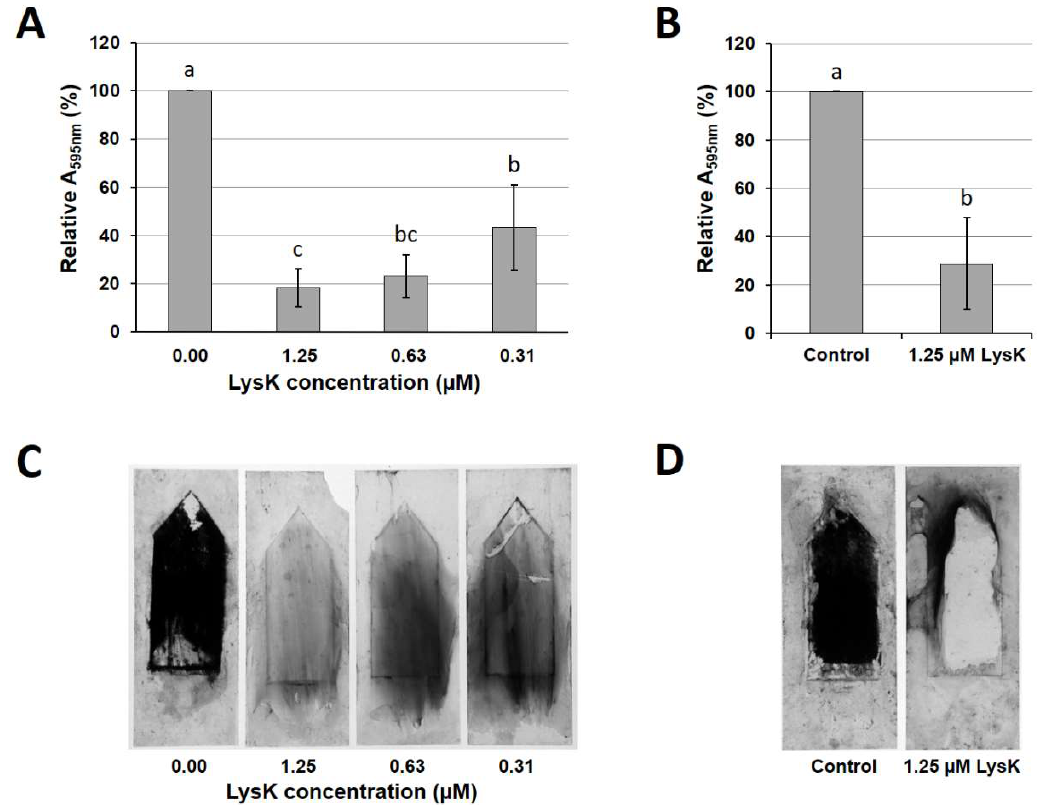
Figure 2. Efficacy of LysK against dynamic S. aureus SA113 biofilms grown on glass surfaces in the Biostream flow cell. Biofilms were grown for 20 h at 19 °C under continuous flow of medium. Glass